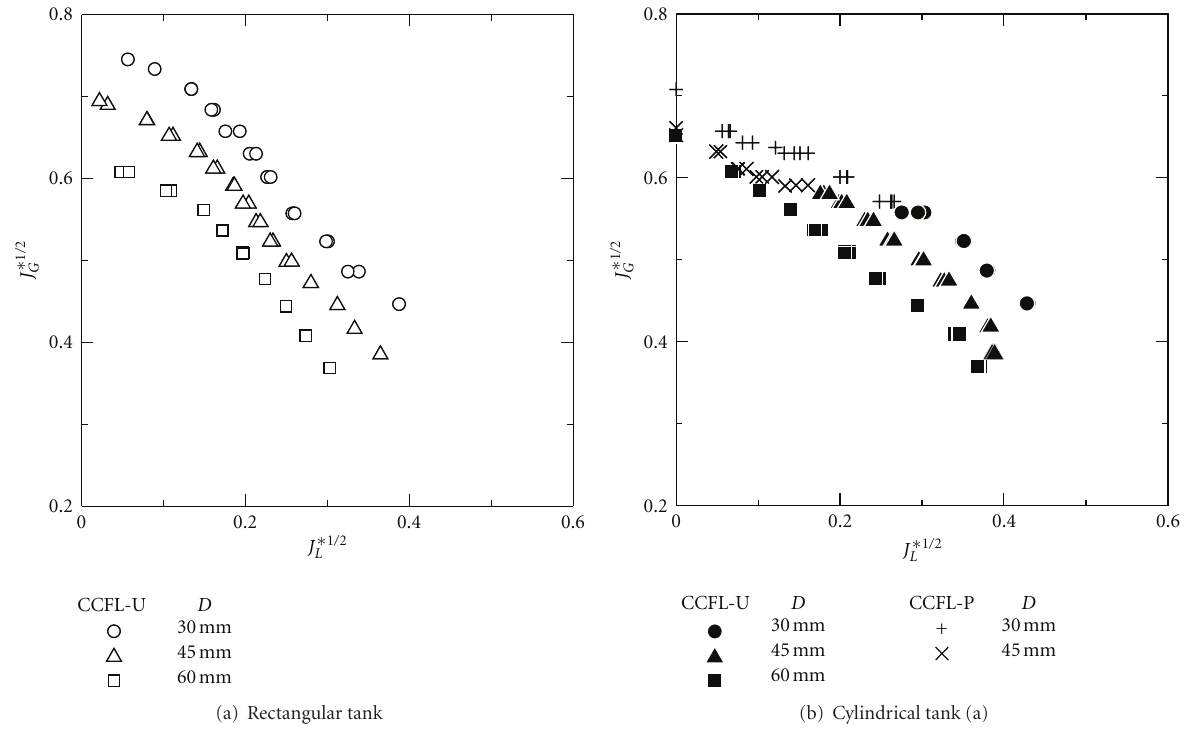
Figure 3: CCFL characteristics for rectangular and cylindrical tanks on J G ∗ 1 / 2 − J L ∗ 1 / 2